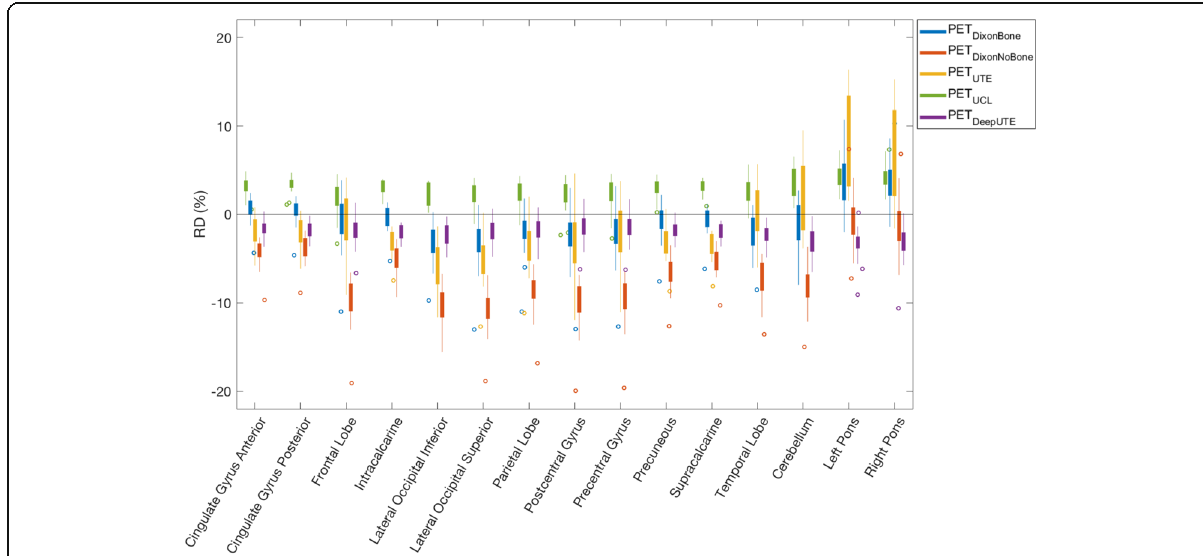
Fig. 2 Relative difference in [ 18 F]FDG uptake between PET MRAC (PET DixonBone , PET DixonNoBone , PET UTE , PET UCL , PET DeepUTE ) and PET CTAC . Top and bottom edges of the boxes indicate 25th and 75th percentiles, while the whiskers extend to the most extreme data points, except for outliers that are marked as